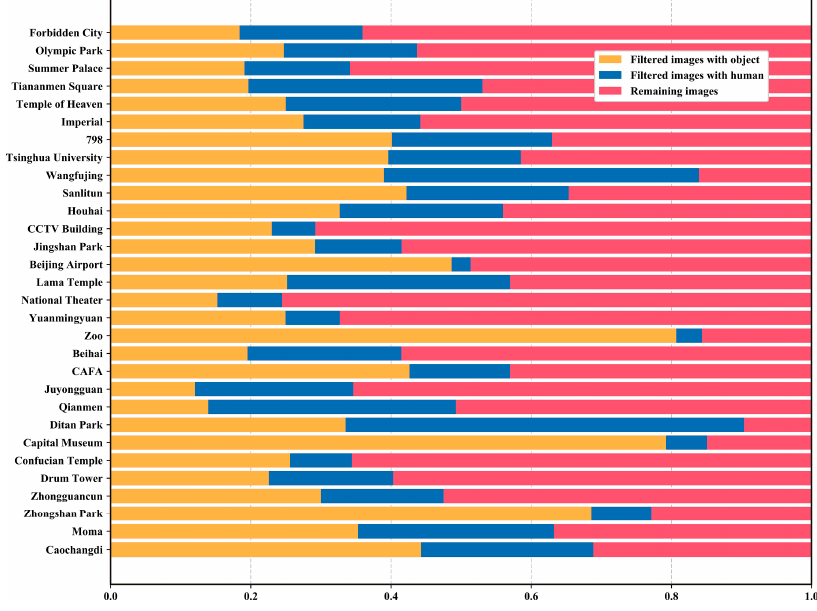
Figure 11. The number of filtered images and the remaining images of each tourist attraction.